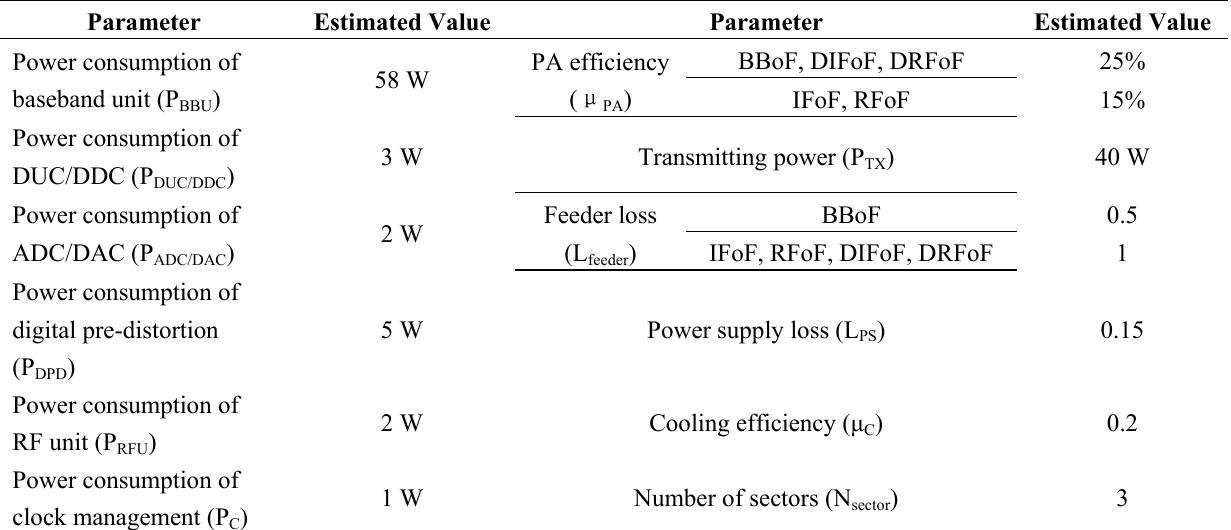
Table 1. Parameters used in base station model.